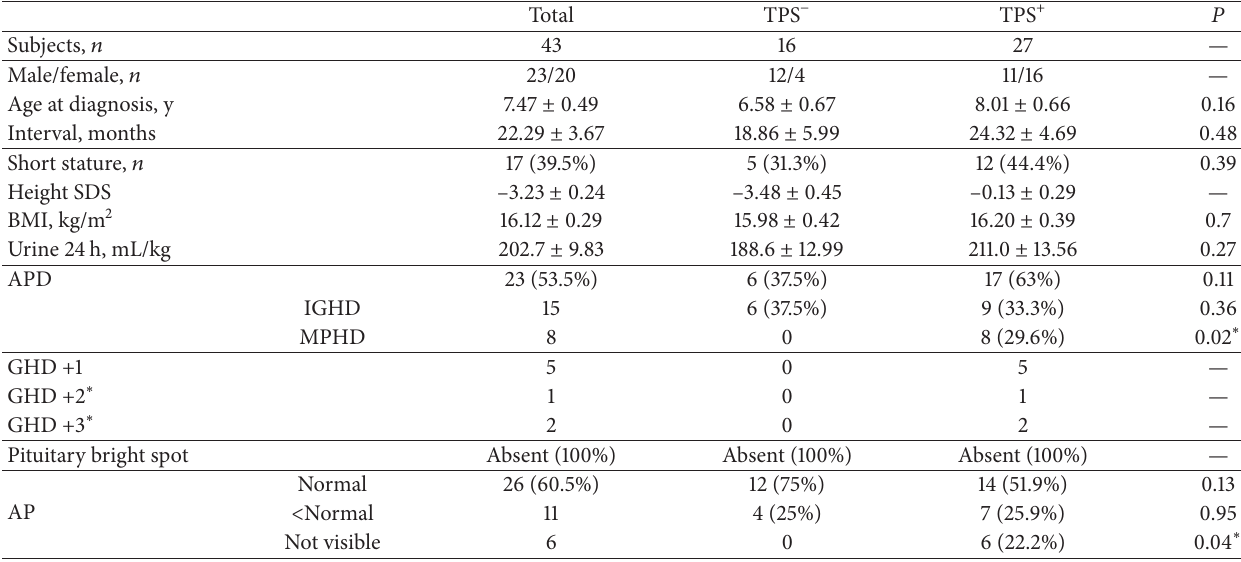
Table 1: Baseline data of all patients with CDI.